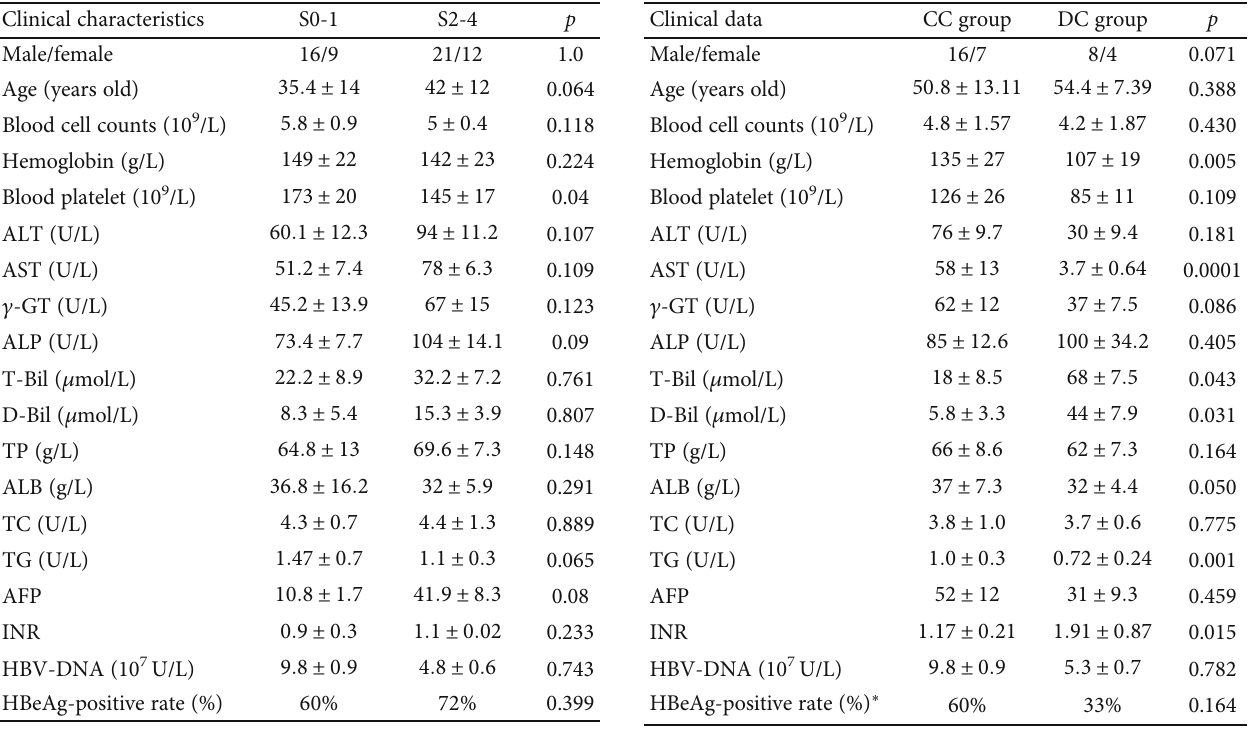
Table 4: Clinical characteristics of the CHB liver cirrhosis CC and DC group cases ( (cid:1) x ± s